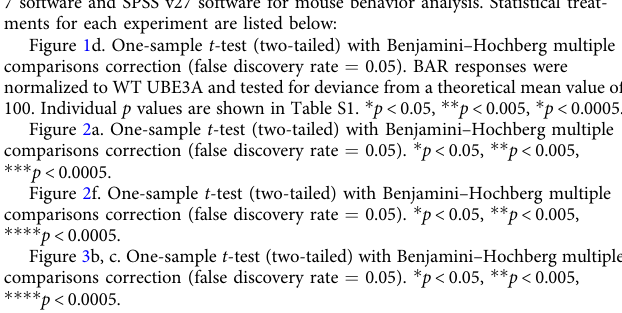
Figure 2f. One-sample t -test (two-tailed) with Benjamini – Hochberg multiple comparisons correction (false discovery rate = 0.05). * p < 0.05, ** p < 0.005, **** p <0.0005. Figure 3b, c. One-sample t -test (two-tailed) with Benjamini – Hochberg multiple comparisons correction (false discovery rate = 0.05). * p < 0.05, ** p < 0.005, **** p